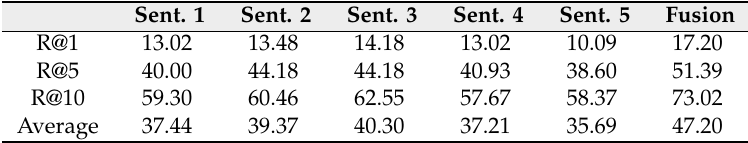
Table 1. Bidirectional text image matching results on our dataset by using E ffi cientNet-B2. Sent. 1 Sent. 2 Sent. 3 Sent. 4 Sent. 5 Fusion